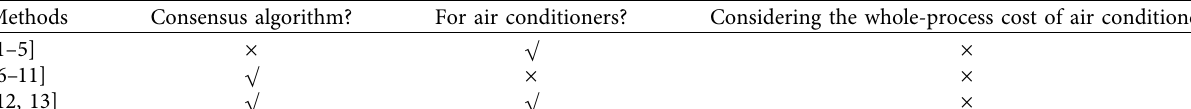
Table 1: Summary of the abovementioned methods.